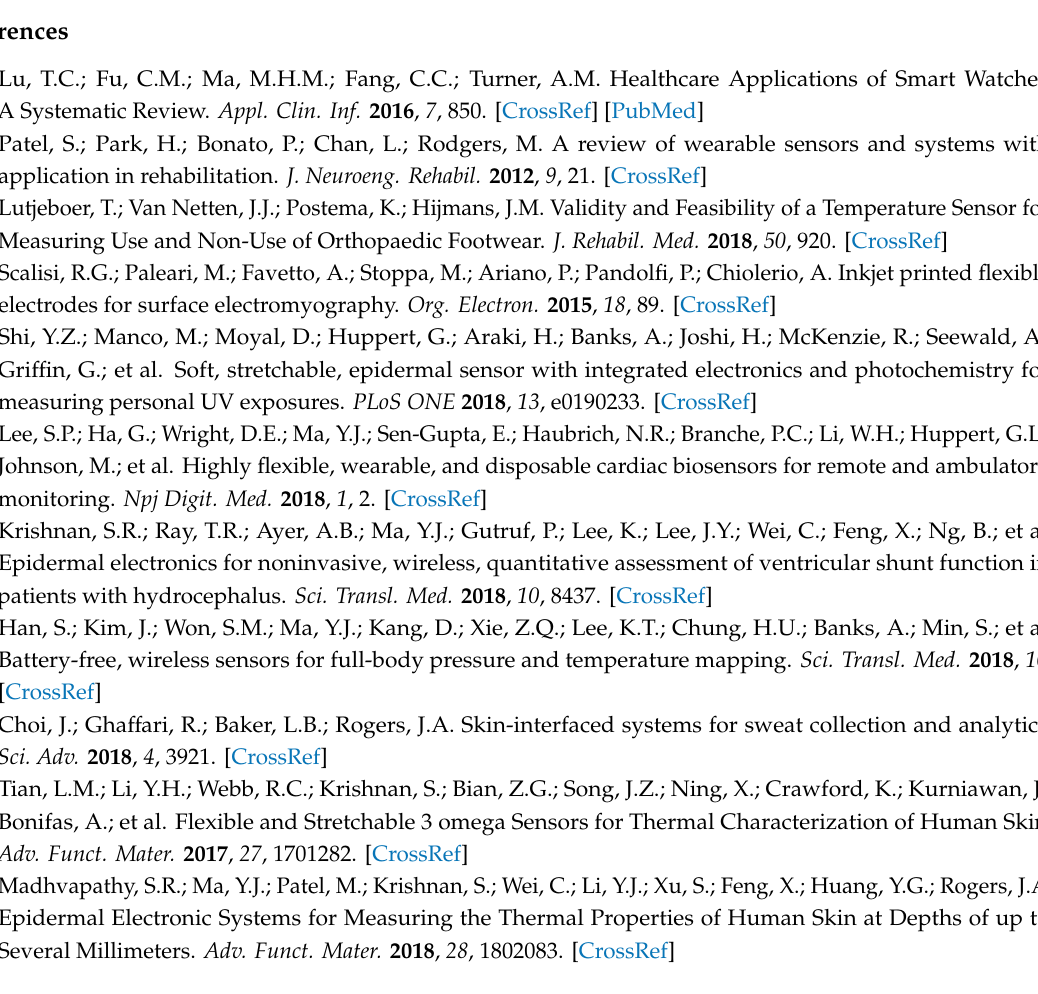
Figure S1. The paper-cut flexible electronic floating on the water, indicating its superior lightweight and softness; Figure S2. The fabrication process of the MoS 2 based back gate transistor on the rigid substrate: (a) prepare a clean SiO 2 / Si substrate. (b) Exfoliate and transfer the MoS 2 nanosheet on the substrate. (c) Pattern the MoS 2 active channel. (d) Deposit a Ti / Au layer, followed by patterning into electrodes; Figure S3. Detailed layout of the design: (a) The CAD structure of the system (Blue trace is the metal mesh, red trace is the PI). (b) Detailed design of the temperature sensor, with a cross-section view in the corner. (c) Detailed design of the photodetector, with a cross-section view in the corner; Figure S4. The paper-cut flexible electronic is connected with an external PCB(FPC-24P) with a heat seal ACF cable; Figure S5. The mechanism of the MoS 2 based photodetector: (a) The band diagram of MoS 2 and Au, in correspondence to vacuum level. (b) The band alignment between the two electrodes and the MoS 2 layer. (c) Under a bias, the band bends according to the bias direction so that the electrons exited from the light illumination are moved to the conduction band; Figure S6. The detail geometries of the three di ff erent cutting patterns. From top to down: linear, triangle and trapezoidal; Figure S7. Stretching the device on the water with a tweezer: (a) The original state of the device. (b) The stretched device with tensile strain of 300%. (c) Photograph of the top part of the device; Figure S8. The bendability test: (a) Photograph of the device bending on the stick of a cotton swab. (b) Testing with di ff erent bending